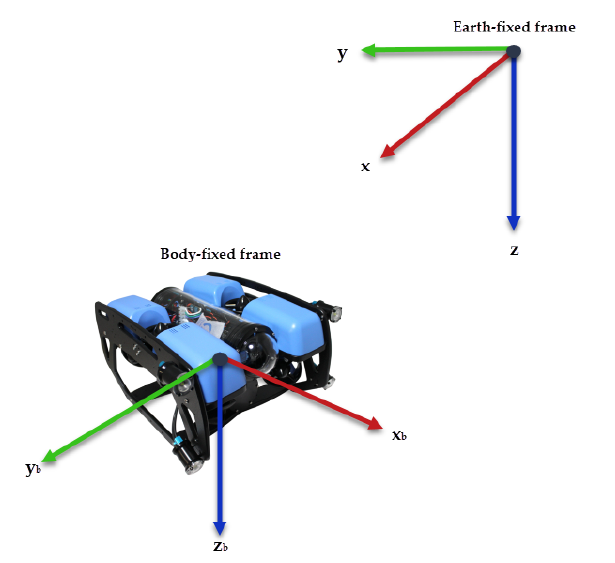
Figure 1. Reference frames for an